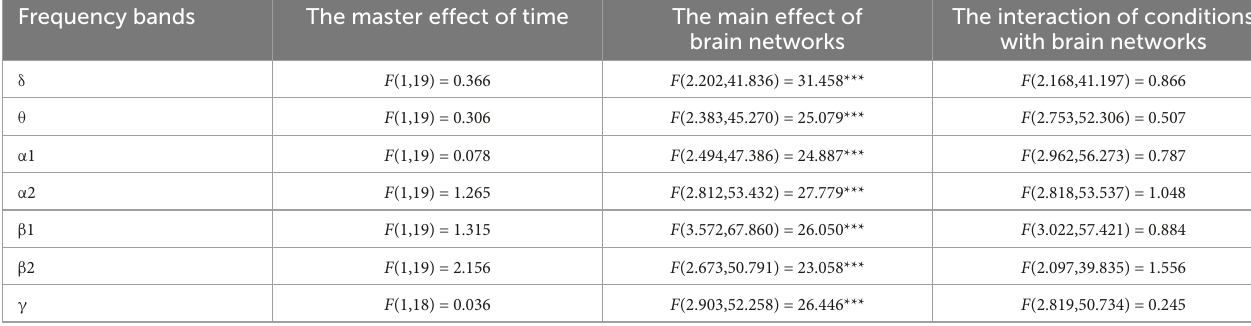
TABLE 5 Results of two-factor ANOVA for brain network energy